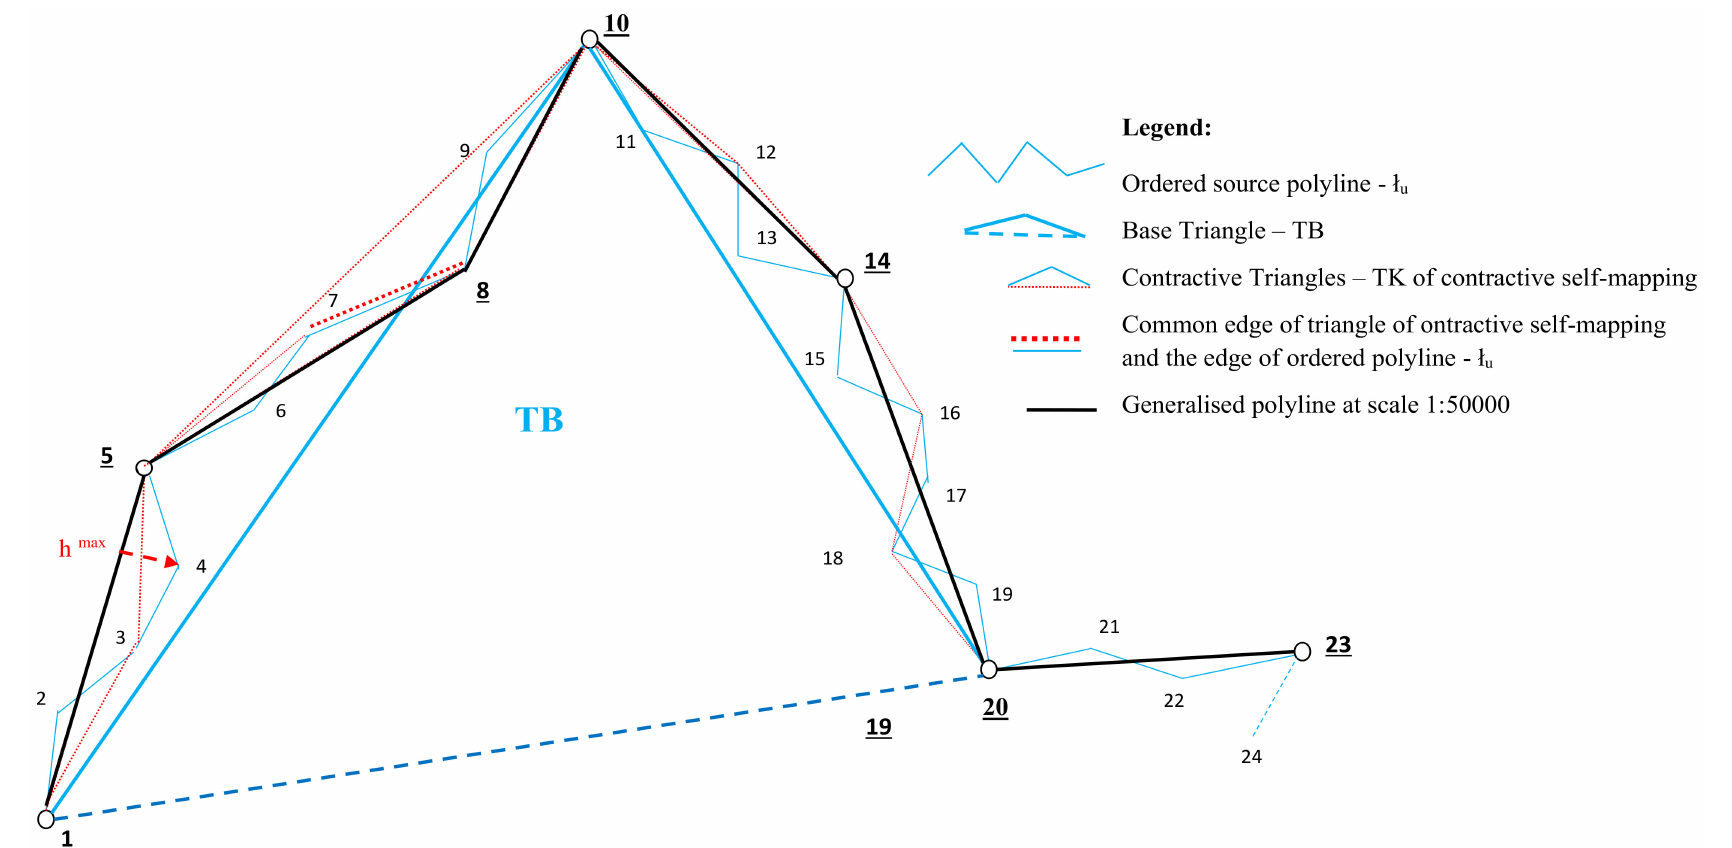
Figure A5. Generalisation of ordered polyline— l u to scale 1:50,000 (from the source scale 1:10,000) with contractive mapping of the triangles TK created in binary tree system and the verification of dimensions of triangles in accordance with Couchy condition and minimum dimensions of Salishchev for: bases-p AS = 38.0 m, p min = 38.0 m ± 6.0 m → p AS < p min , heights-h AS = 16.5 m, h max = 9.0 m ± 3.5 m → h AS > h max